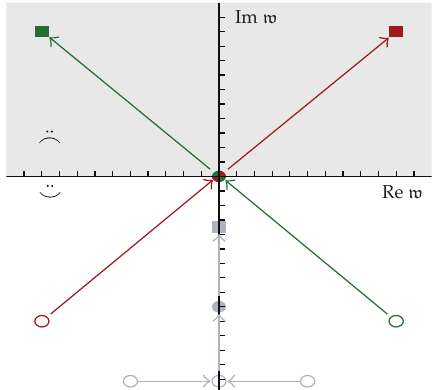
(cid:11) d I . (cid:11) (cid:11) d I : ◦ < d crit ,